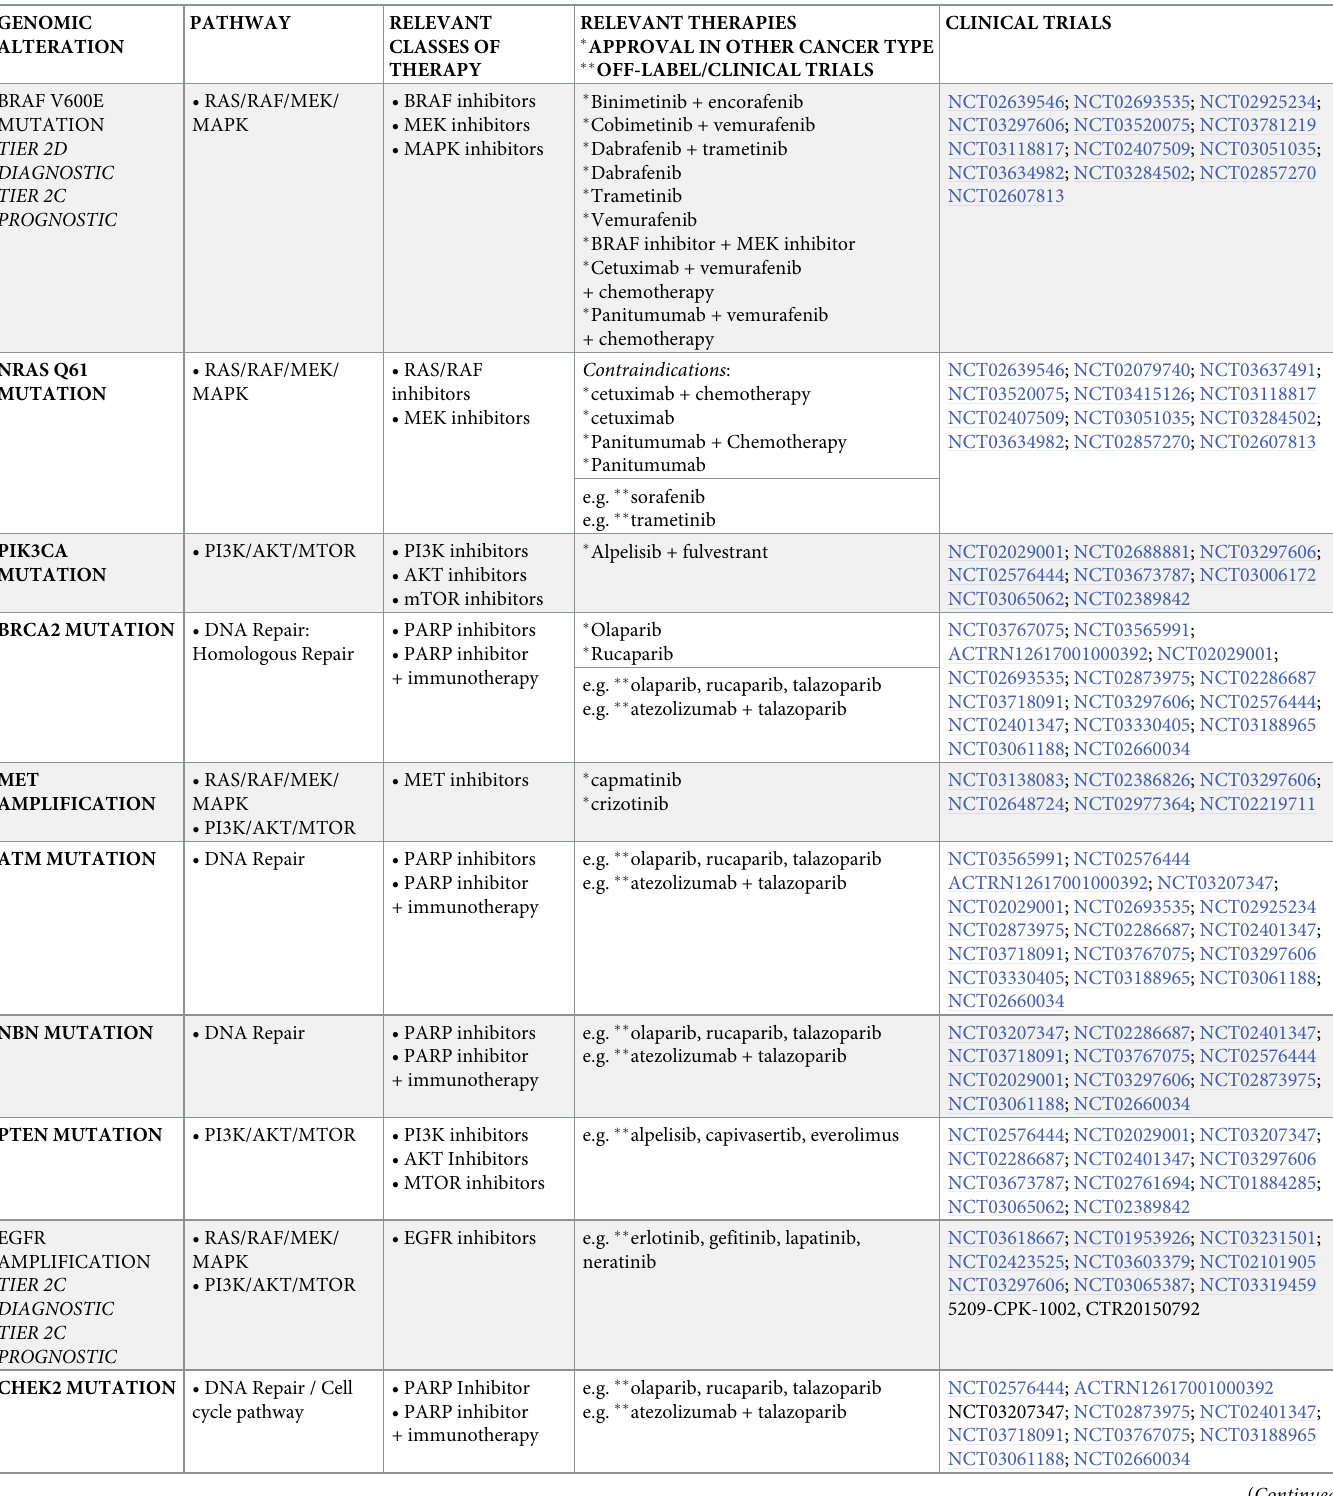
Table 1. Actionable drug targets in